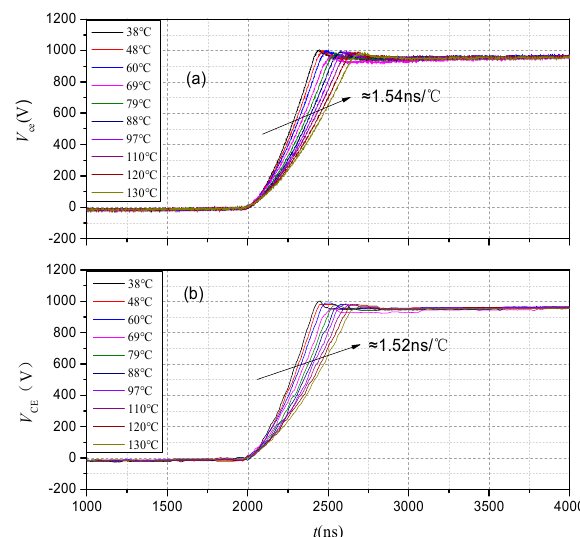
Figure 9. IGBT turn-off transitions under different case temperatures: ( a ) direct sampling at sampling rate of 1GS/s; ( b ) sparse reconstruction.